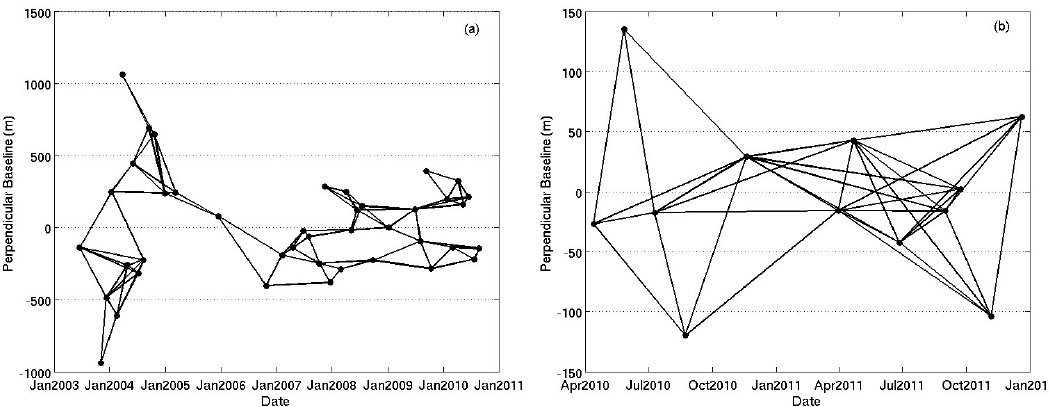
Figure 2. Networks of the small baseline interferograms obtained from ( a ) Envisat ASAR and ( b ) TerraSAR-X images used for SBAS InSAR analysis for land subsidence in Beijing.